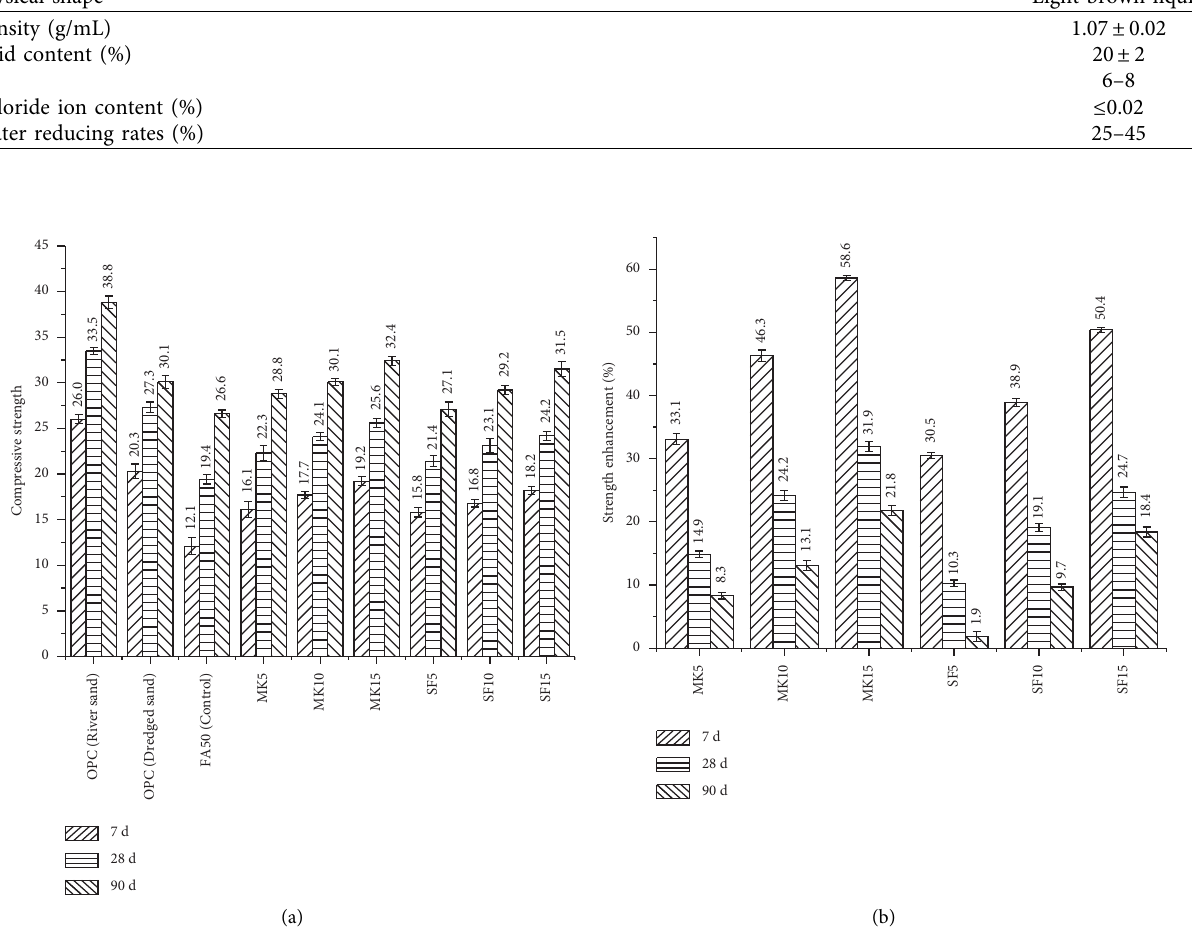
Figure 4: (a) Compressive strength of mortars and (b) its growth rate.